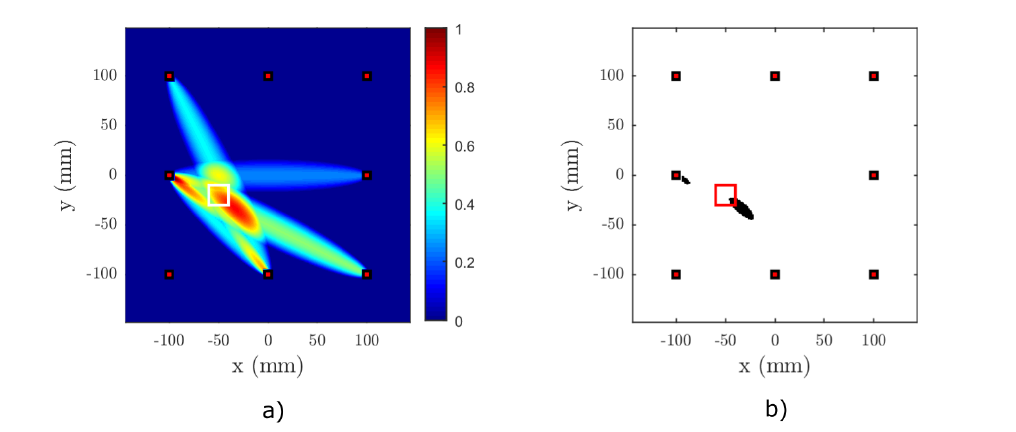
Figure 9. Result of Test Case 4 for nonlinear RAPID imaging on a simulated anisotropic plate, ( a ) without binarization and ( b ) with binary thresholding. The excitation waveform was a three-cycle sine burst, at 50kHz with the Hanning window. The center of the delamination is located at [ − 50, − 20]. The binarization threshold was set to t P = 0.8, the shape factor to β = 1.015 and the SDC threshold to t SDC = 0.25. The actual location of the delamination is marked with a white square in (a) and a red square in